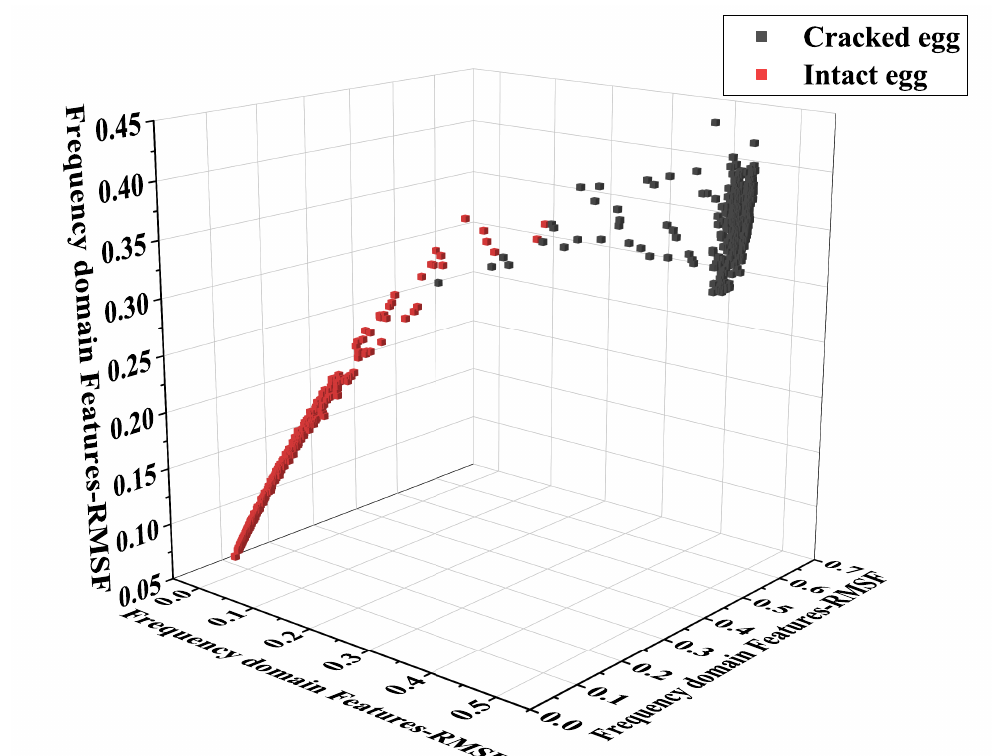
Figure 14. Feature distribution diagram. ( a ) Time domain features. ( b ) Wavelet domain features.